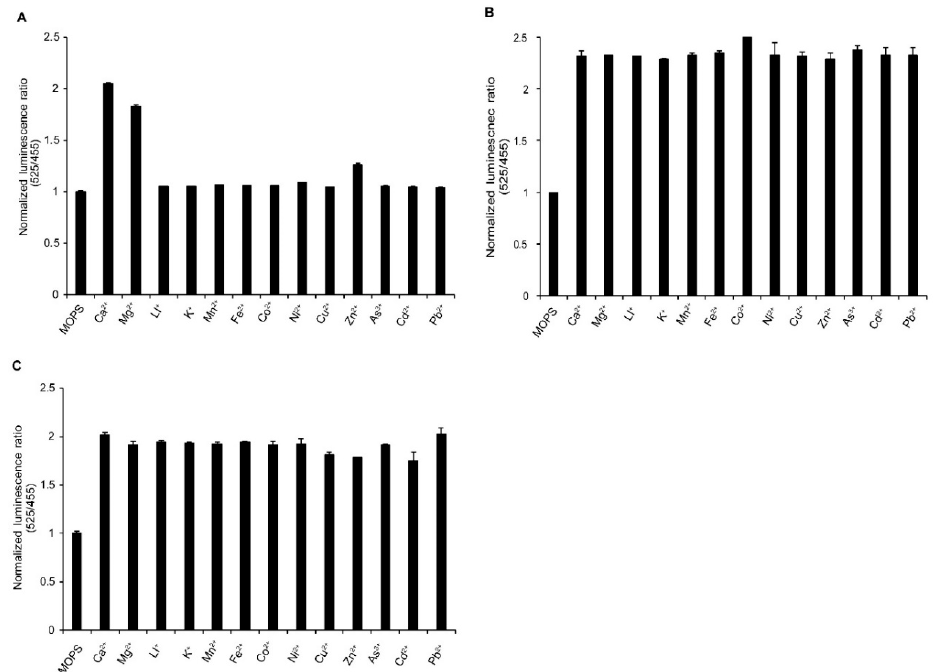
Figure 3. Specificity and selectivity of LOTUS-W for calcium and magnesium ions. ( A ) The specificity of LOTUS-W for Ca 2+ and Mg 2+ . Emission ratios were measured in the presence of each metal ion. ( B , C ) The selectivity of LOTUS-W to Ca 2+ (B) or Mg 2+ (C), upon mixing with different metal ions. LOTUS-W was premixed with each metal ion, and Ca 2+ or Mg 2+ was added. Bioluminescence emission ratio was normalized (n = 3) to the count without additional metal ions (MOPS).